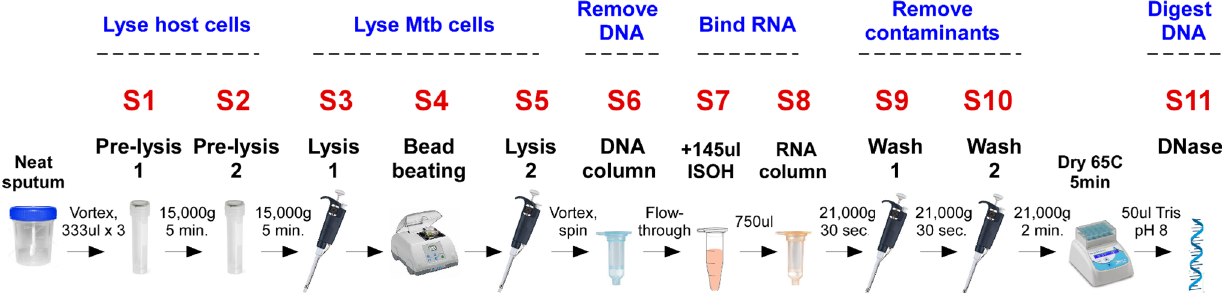
Figure 1. Schematic summary of the Mtb RNA purification protocol from sputum. Numbers on top of each step refer to the Supplemental File containing optimization data for that particular step of the protocol. The final protocol can be found in Tables